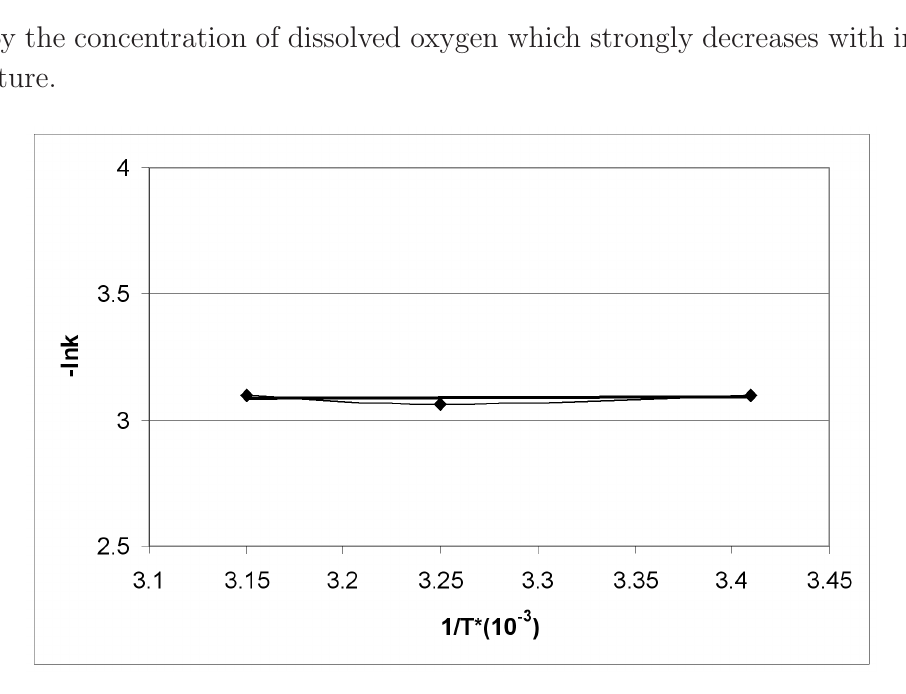
Fig. 8 Dependency on temperature of rate constant